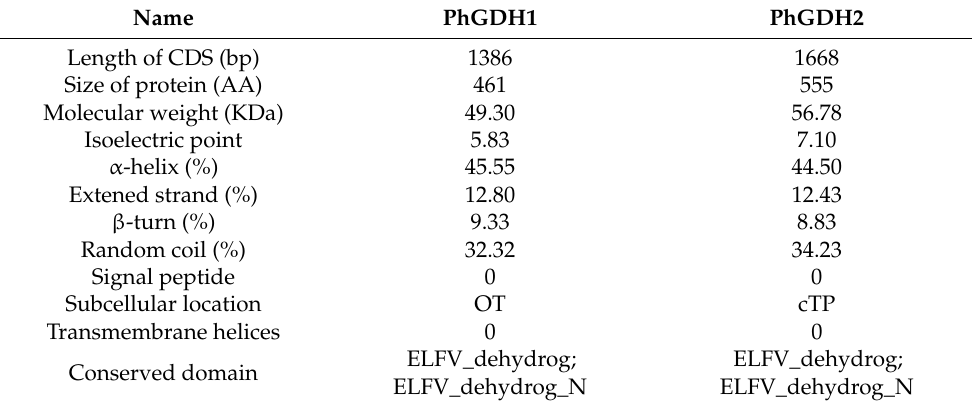
Table 1. Comparisons of PhGDH1 and PhGDH2 in terms of gene/protein structure, subcellular localization, and activities. AA, amino acids; CDS, coding sequences; OT, other; cTP, chloroplast transit